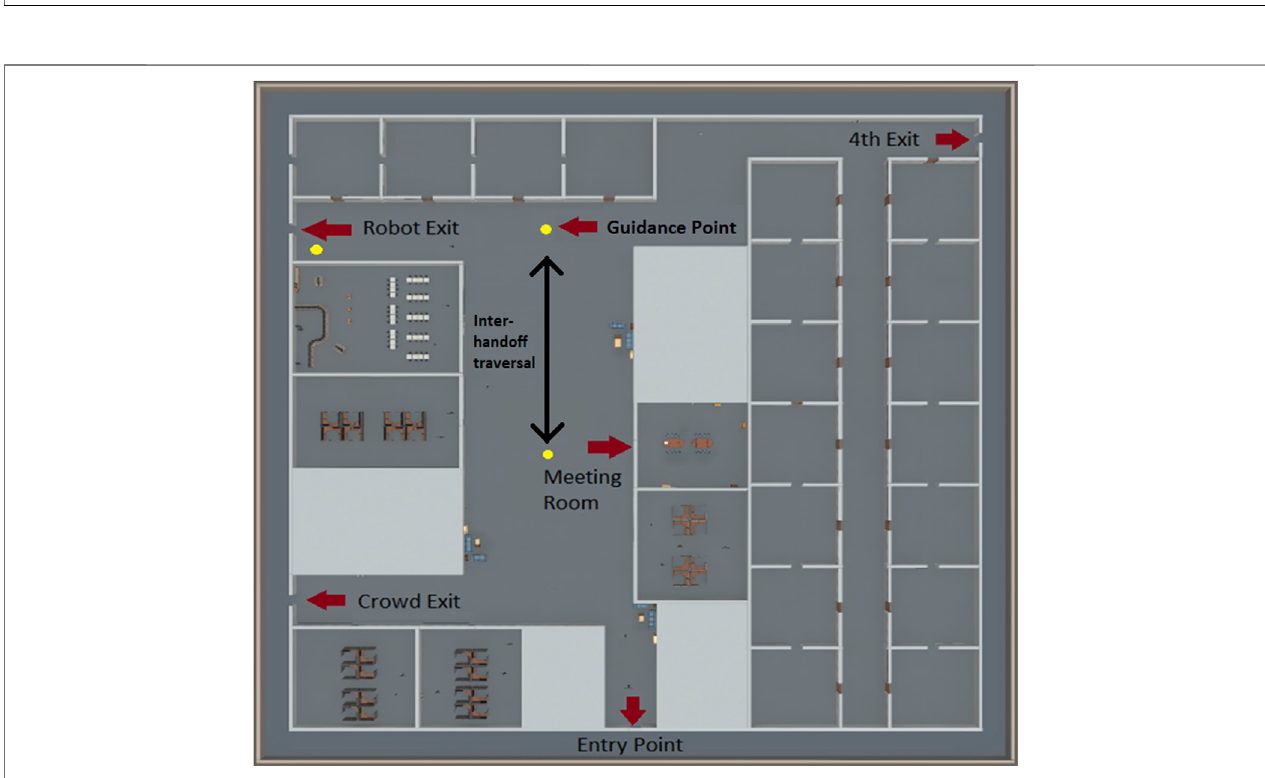
FIGURE 4 | An overhead map of our emergency evacuation environment. The red arrows highlight several key locations used for our emergency evacuation experiments. The yellow circles depict guidance points. The black arrow depicts an inter-handoff traversal.